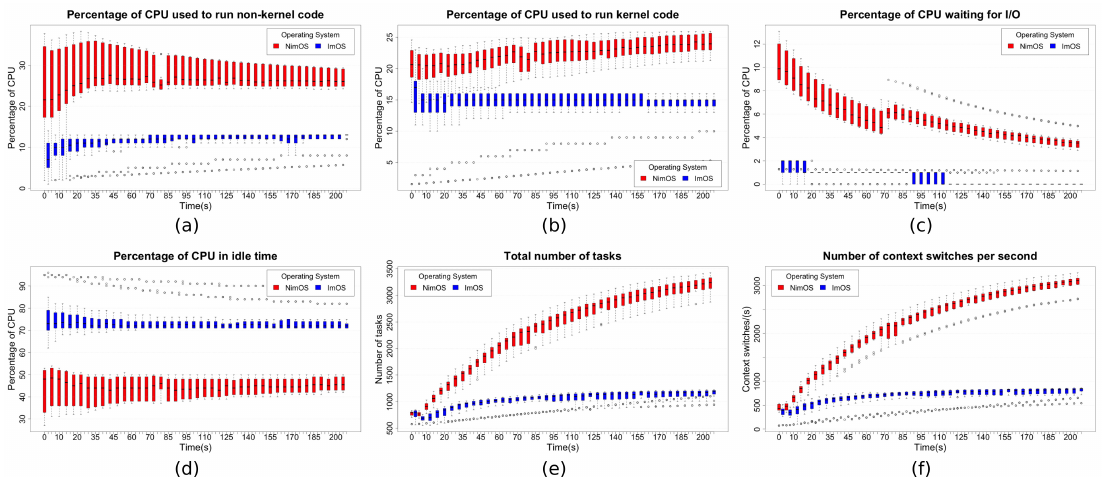
Figure 8. Wearable prototype CPU performance when running not improved operating system (NimOS) and improved operating system (ImOS): ( a ) Percentage of CPU time running non-kernel code. ( b ) Percentage of CPU time executing kernel code. ( c ) Percentage of CPU time waiting for input/output (I/O). ( d ) Percentage of CPU time in idle time. ( e ) Total number of tasks managed by the system. ( f ) Total number of context switches per